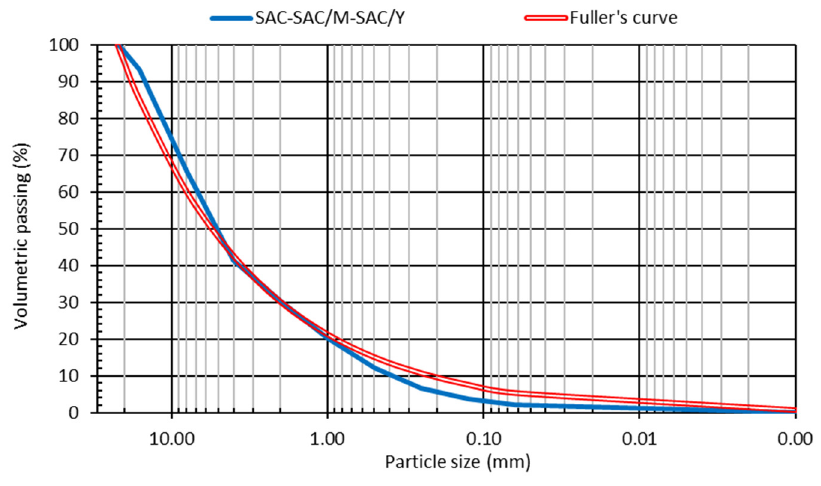
Figure 4. Joint gradation of the mixes.